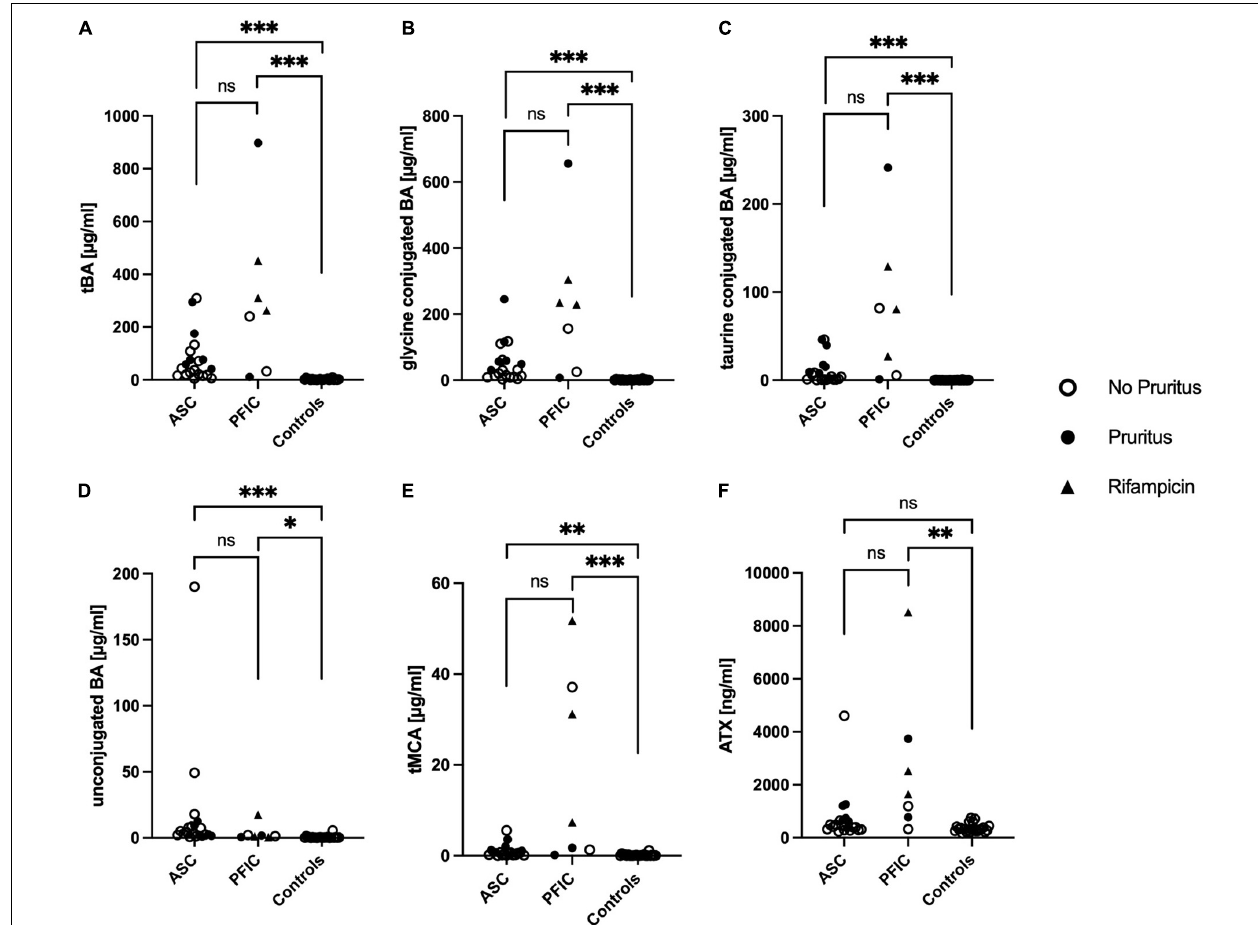
FIGURE 1 | Total bile acids (tBA) (A) , taurine conjugated BA (B) , glycine conjugated BA (C) , unconjugated BA (D) , total muricholic bile acids (tMCA) (E) , and autotaxin (ATX) antigen levels (F) in pediatric patients with ASC, PFIC and healthy age-matched controls. Significances are indicated with bars and stars within the diagram. ∗ p < 0.05; ∗∗ p < 0.01; ∗∗∗ p <